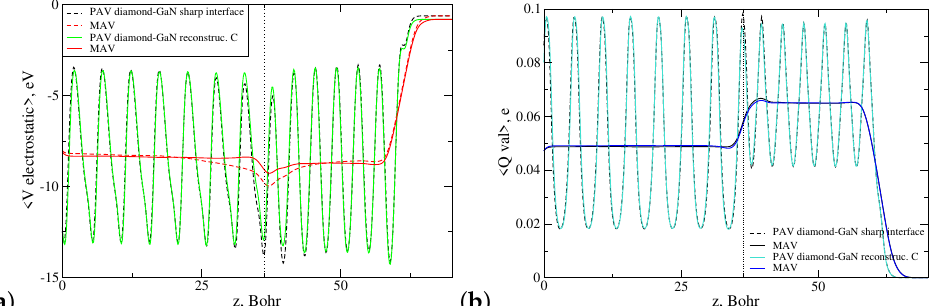
Figure 15. Course of laterally (PAV) and macroscopically (MAV) averaged profiles of the ( a ) electro- static potential and ( b ) valence electron charge density in the diamond–GaN heterostructure with the N-C abrupt and reconstructed interface types. The applied reconstruction pattern is 3 N + 1 C N . A dotted line points to the average z-th position of the topmost N